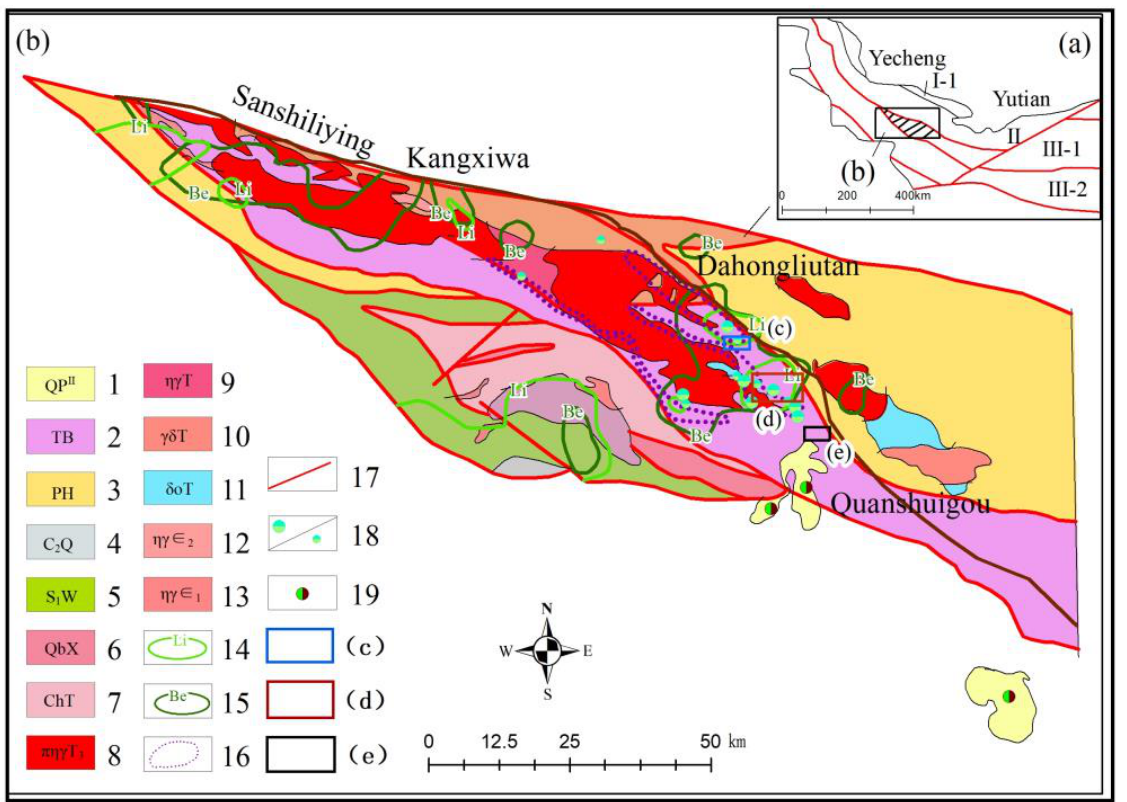
Figure 1. Geographical location of the research area (revision from [39]). 1 — Quaternary salt lake; 2 — Bayankalashan group of the Triassic; 3 — Permian Huangyangling group; 4 — Upper Carbonifer- ous Qiatier group; 5 — Wenquan Gou group of the Lower Silurian; 6 — Qingbaikou system, Xiaoer Valley formation; 7 — Tianshuihai group of the Changcheng system; 8 — Late Triassic two-mica monzogranite; 9 — Triassic monzogranite; 10 — Triassic granodiorite; 11 — Triassic quartz diorite;